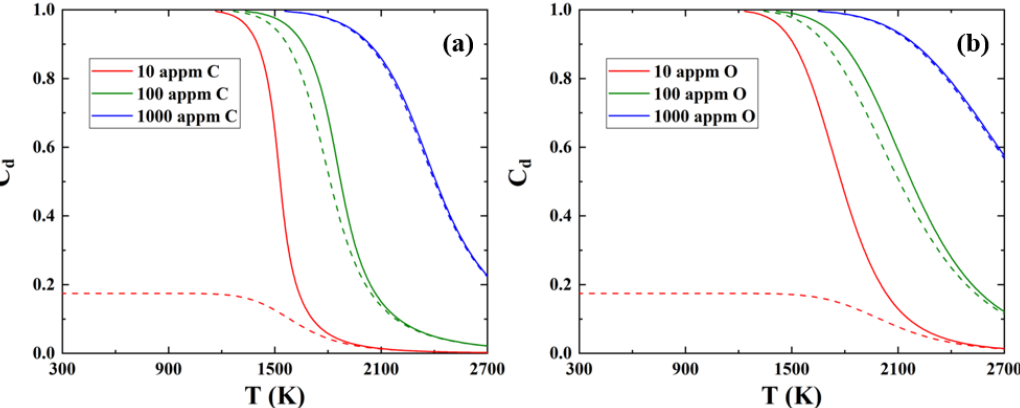
Figure 5. Temperature dependence of the ( a ) C and ( b ) O concentration segregated in the dislocation core for three typical nominal concentrations of solutes and for two dislocation densities, 10 12 m − 2 (solid lines) and 10 15 m − 2 (dashed lines).